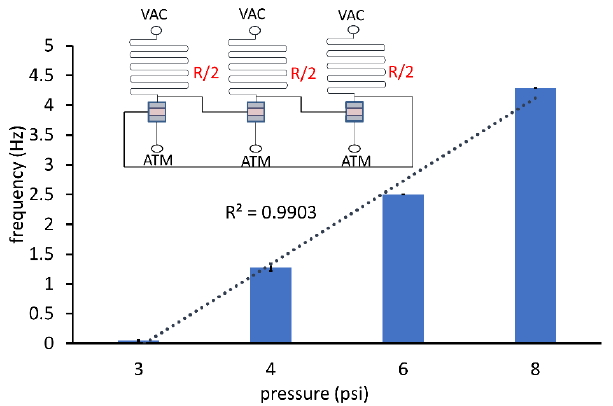
Figure 5. Oscillator frequency response with inverter stages having half the pull-up resistance R /2 (top) of the device shown in Figure 1C.